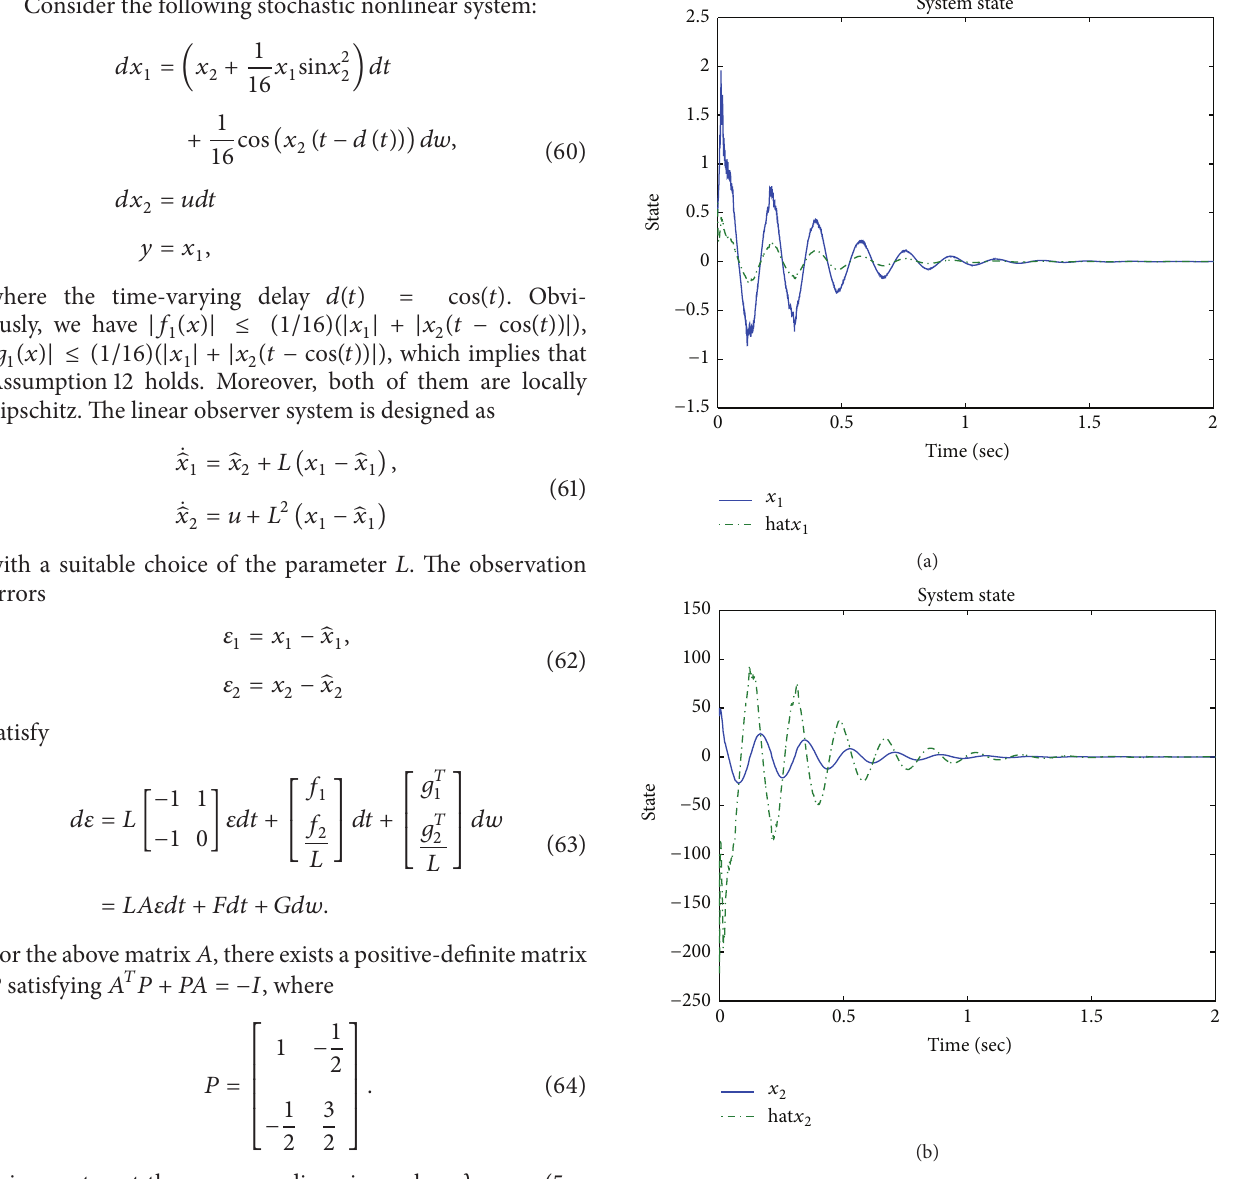
Figure 1: The state